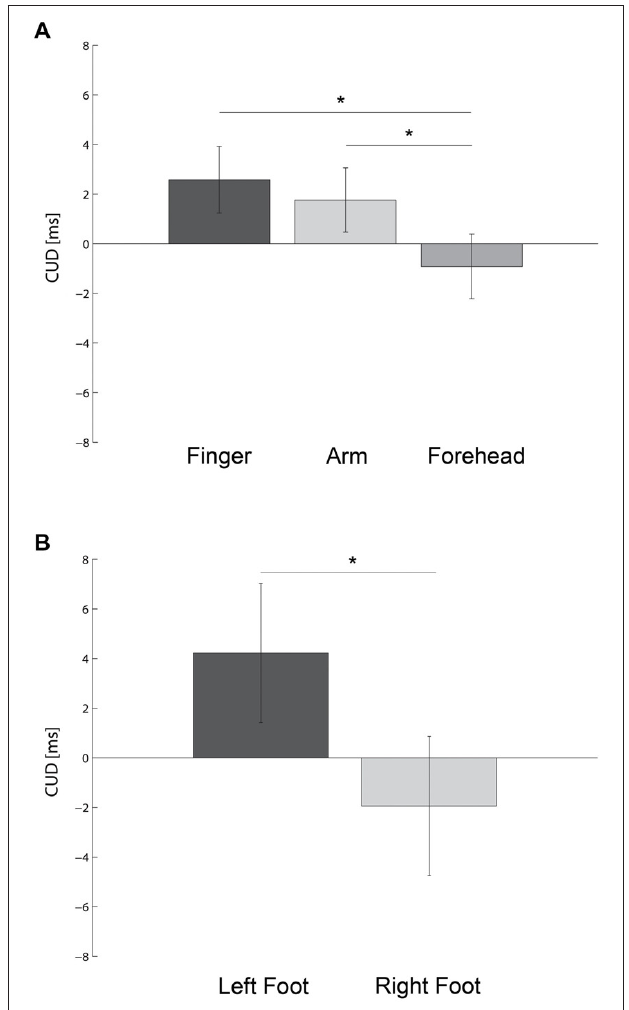
Error bars indicate the 95% Confidence Interval of the within participants variability ( ± CI). * denotes P <